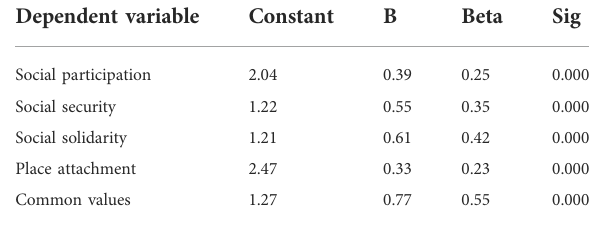
TABLE 10 Branding regression on social capital